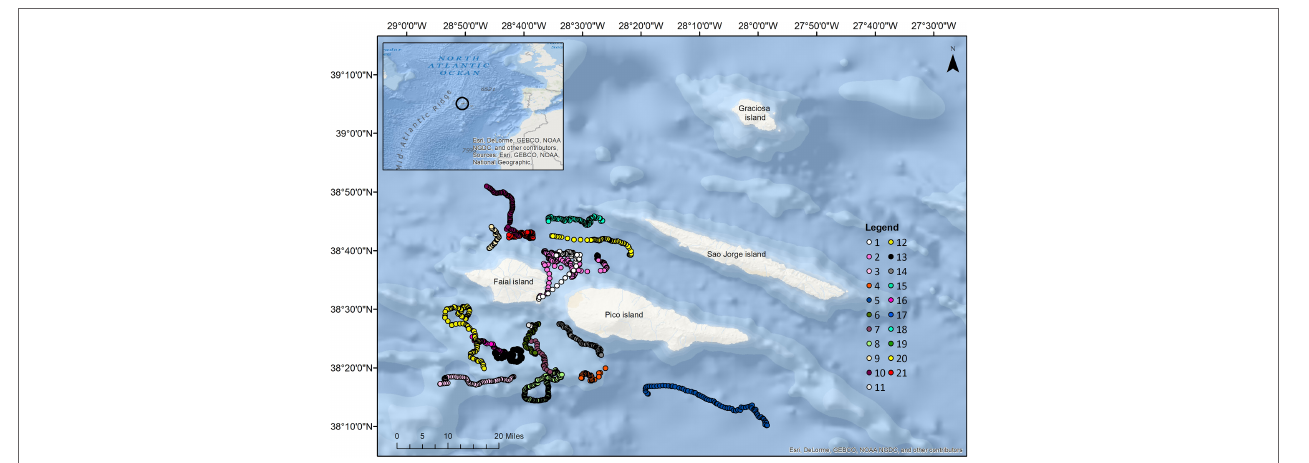
FIGURE 1 | Map of the study area showing the tracks of 21 fin whales (color coded by individual whale) tagged with TDRs. Tracks were plotted using the GPS coordinates retrieved at surfacing locations of tagged whales during focal follows and represent on average 25% of the total duration of tag